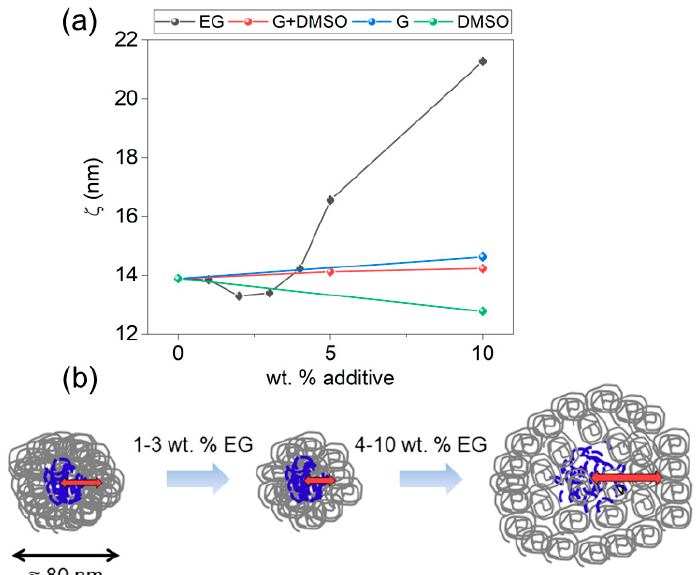
Figure 4. ( a ) Correlation length ξ for PEDOT:PSS grains at different concentrations of EG (black points), G (blue points), DMSO (green points), and the blend (G+DMSO) (red points). ( b ) Repre- sentation of the effect of EG on the PEDOT:PSS grains within the dispersion. Red arrows represent the idea behind correlation length ξ . Scheme not in scale.